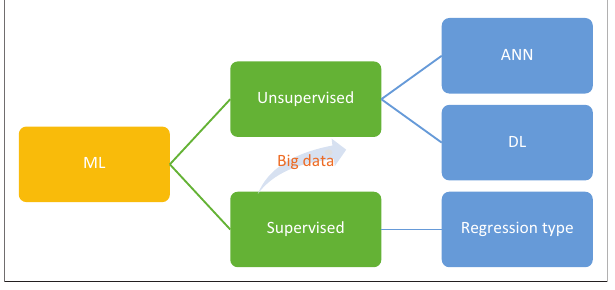
FIGURE 2: Machine learning within artificial